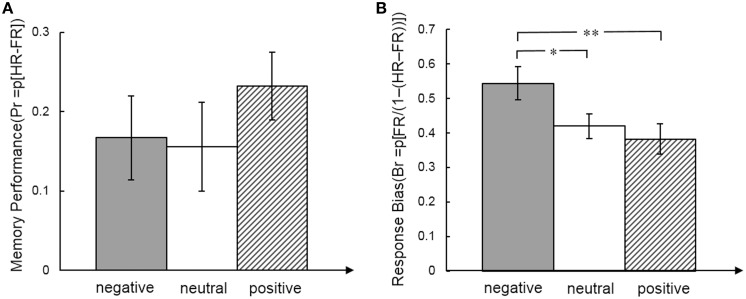
Memory performance (A) and response bias (B) measures for emotional face expression. Post-hoc t-tests indicated differences between emotional face expressions. *p < .05; **p < .01.